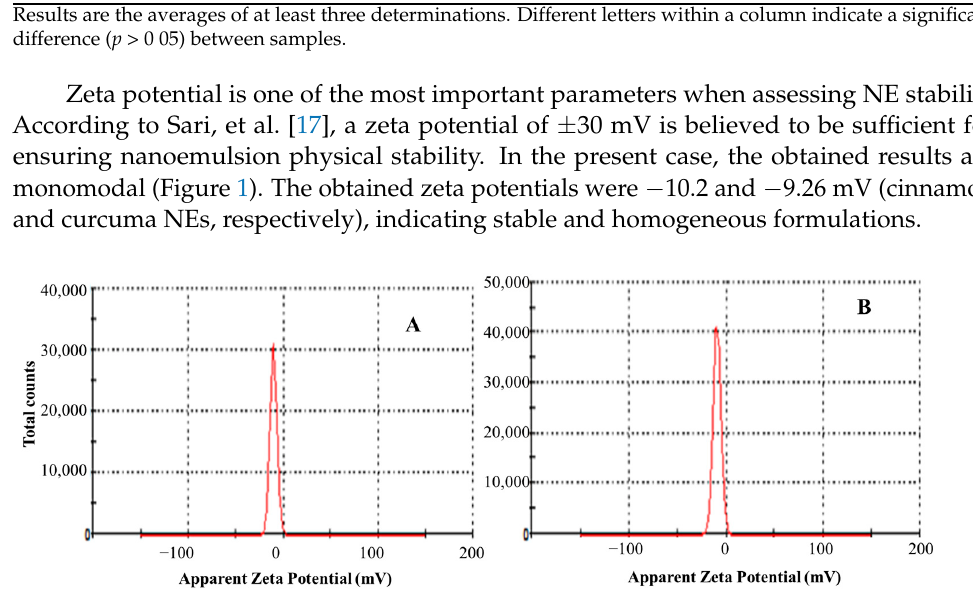
Figure 1. Zeta potential of curcuma ( A ) and cinnamon ( B ) nanoemulsions. Results are the means of at least three replications.